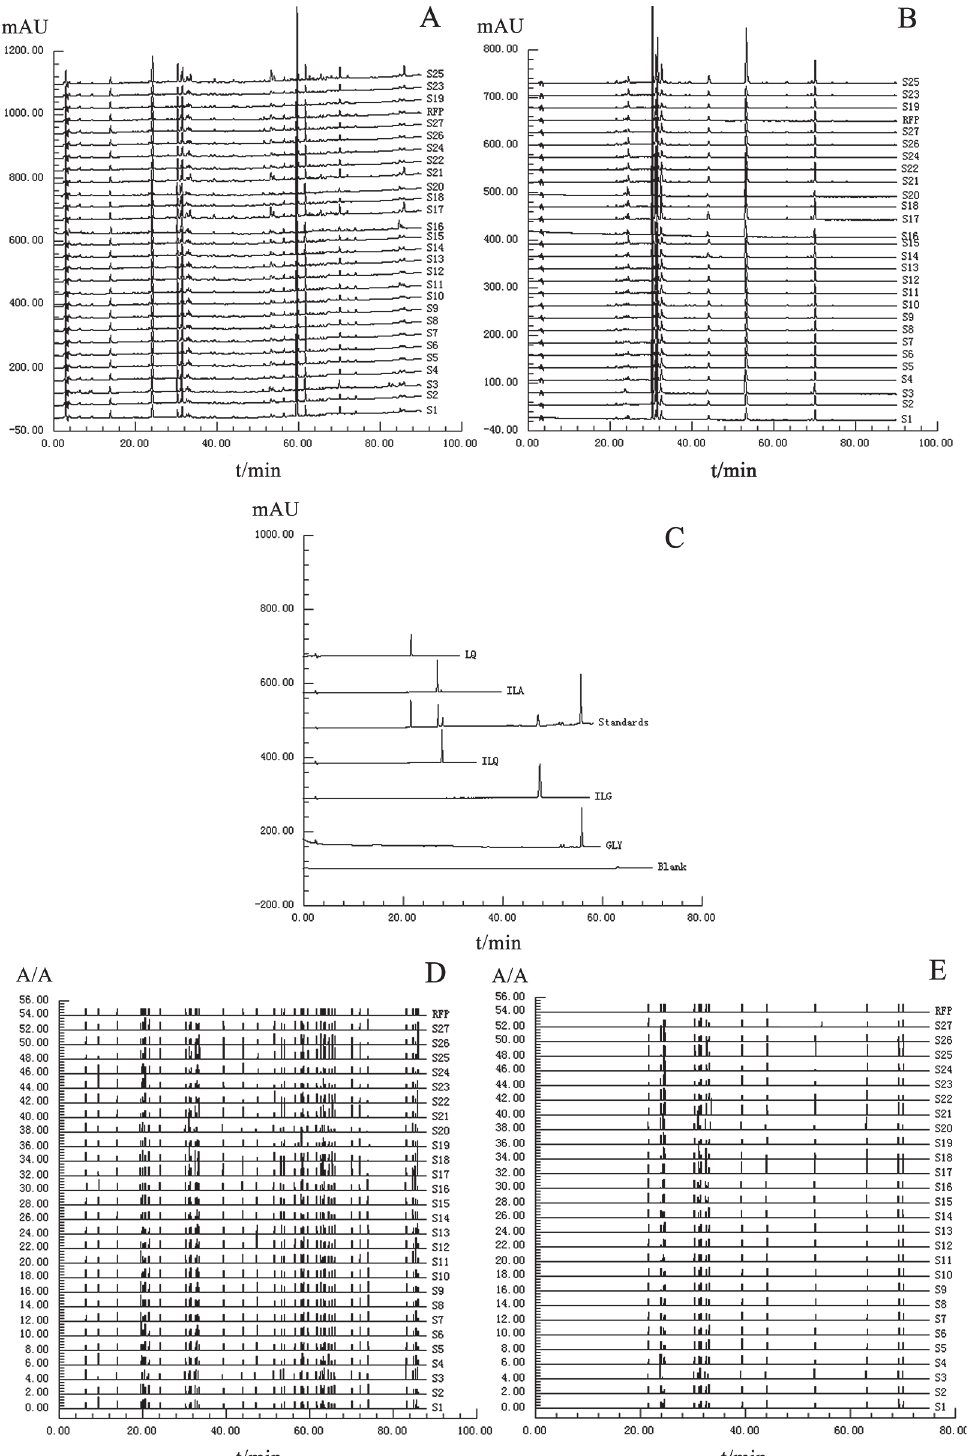
Fig 3. Typical chromatograms and ratio chromatograms of 27 batches of CBAT samples at 5 wavelengths, as well as the chromatograms of marker compound standards. The chromatograms: (A) 250 nm (B) 360 nm (C) standards, the ratio chromatograms: (D) 250 nm (E) 360 nm.